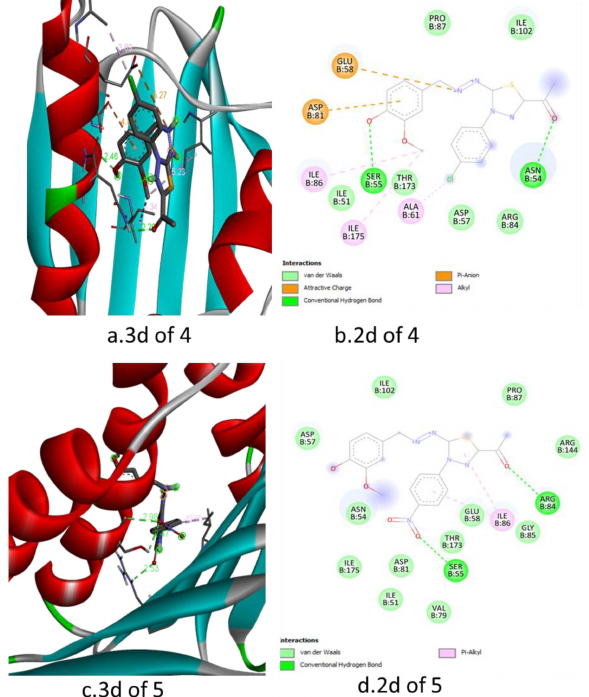
Figure 8. Interaction of the docked compounds 4 and 5 with bacterial DNA gyrase